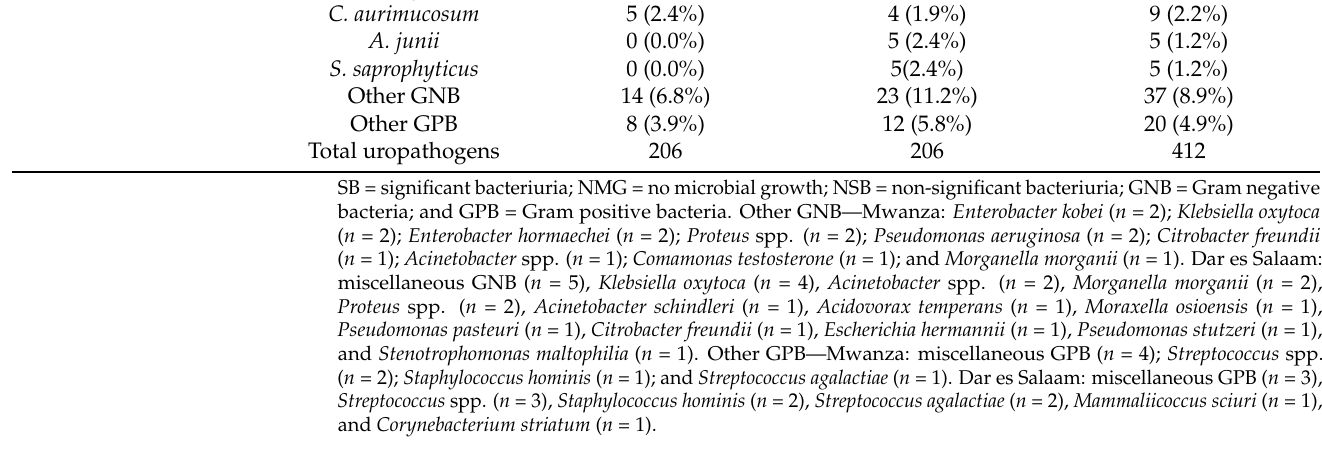
Table 3. Percentages resistance of Gram negative uropathogens causing community-acquired urinary tract infections in